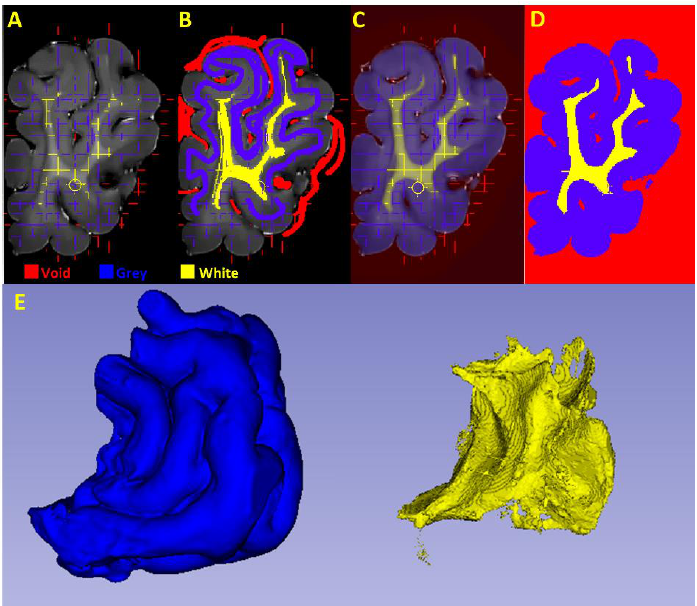
Figure 5. Segmentation of the frontal cortex in a T1-weighted image. Segmentation used supervised machine learning in ilastik. Tissue labels “Void”, “Grey matter” or “White matter” are coloured red, blue and yellow respectively. ( A ) Original coronal T1-weighted MRI slices, with labelled segments in orthogonal planes indicated by coloured lines. ( B ) Painted segmentation for training in the current plane. ( C ) Probability map of tissue classification, and ( D ) the final tissue segmentation used for quantification. The final 3D volume renderings generated in 3D slicer can be seen in ( E